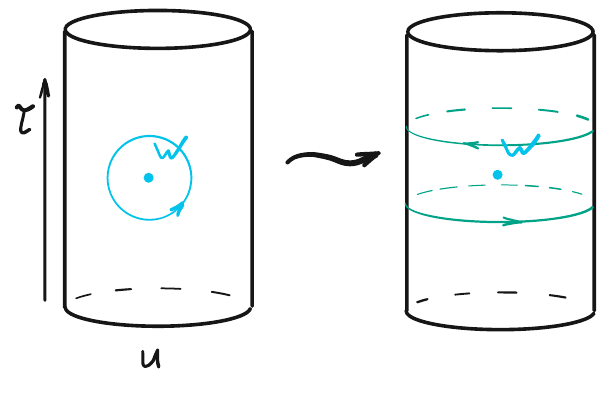
Figure 1 . Deformation of the blue contour (2.3) into the green one